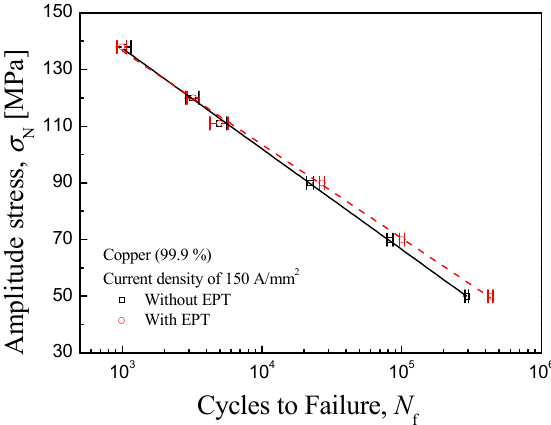
Figure 4. S–N curve of notched specimens with and without current pulsing (j = 150 A/mm 2 , 4 times in 5 s).